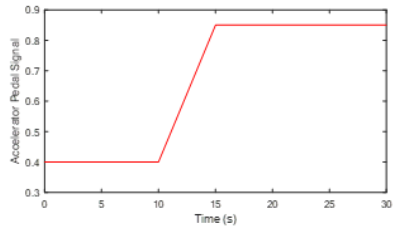
Figure 16. Acceleration pedal.